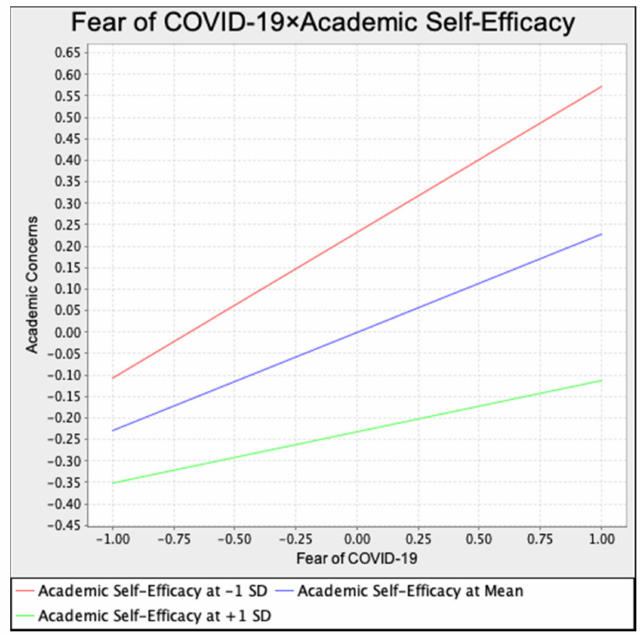
Figure 2. Simple slope